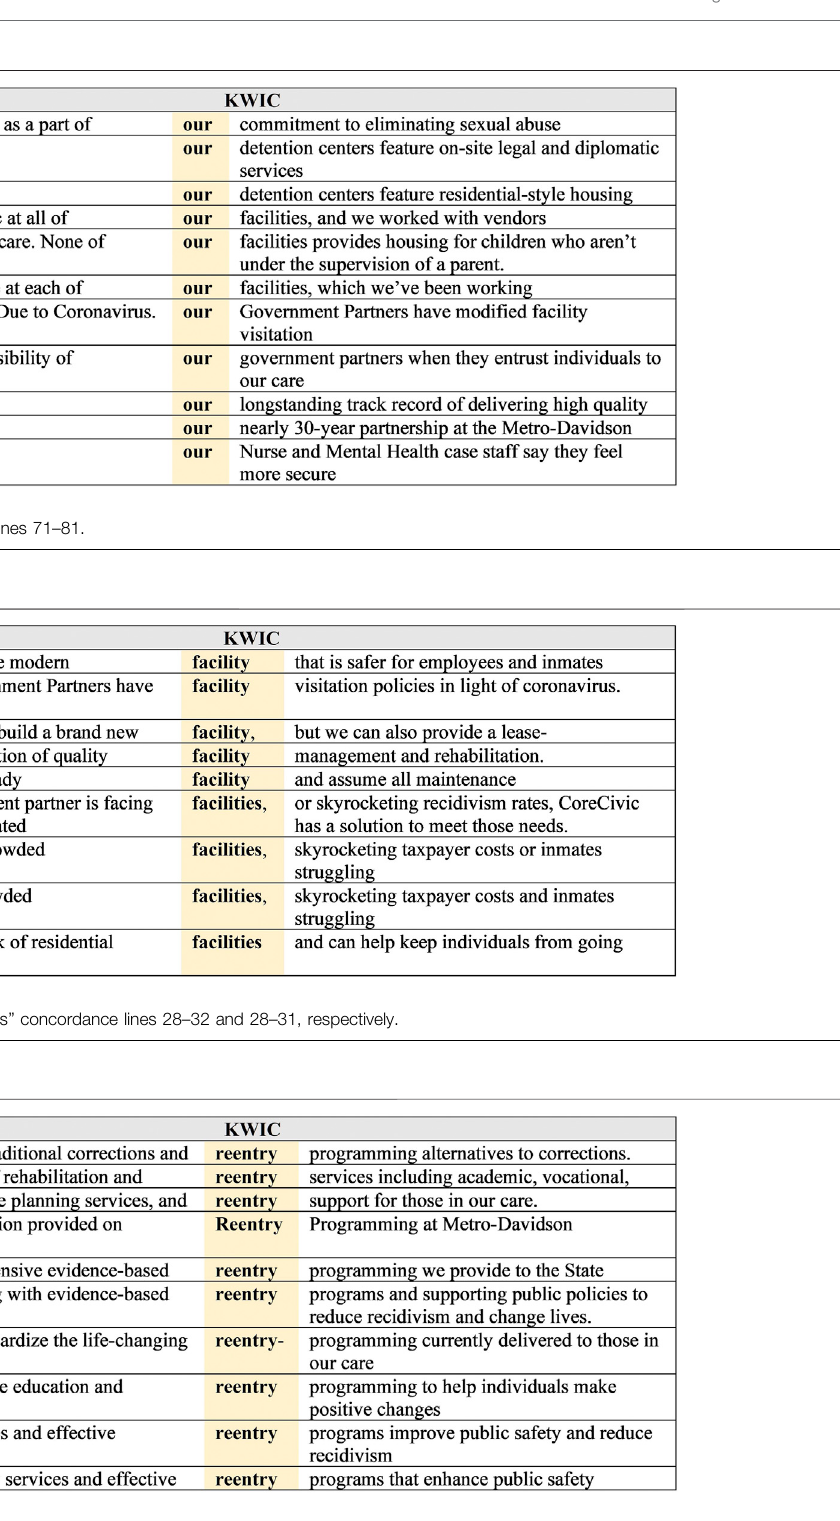
FIGURE 4 | CoreCivi corpus, “ reentry ” concordance lines 2 –